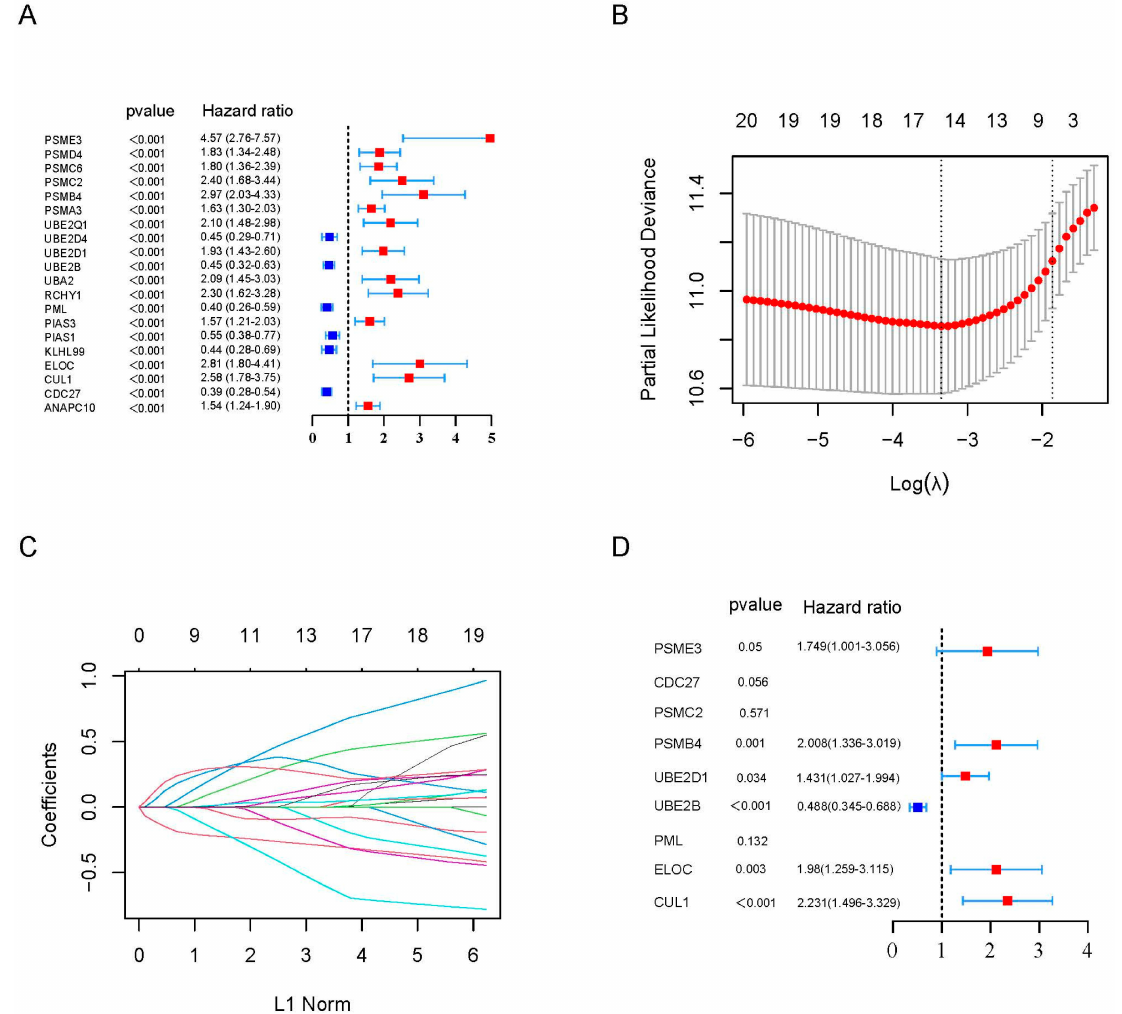
Figure 1. Establishment of the UPPGs–related prognostic signature. ( A ) Univariate cox regression analysis of UPPGs related to MM survival in the training cohort. p < 0.001 was considered to be statistically significant. ( B ) LASSO cox regression analysis for the optimal parameter (lambda, λ ). ( C ) LASSO coefficient profiles of 20 UPPGs. ( D ) Multivariate cox analysis of nine identified UPPGs associated with MM risk in the training